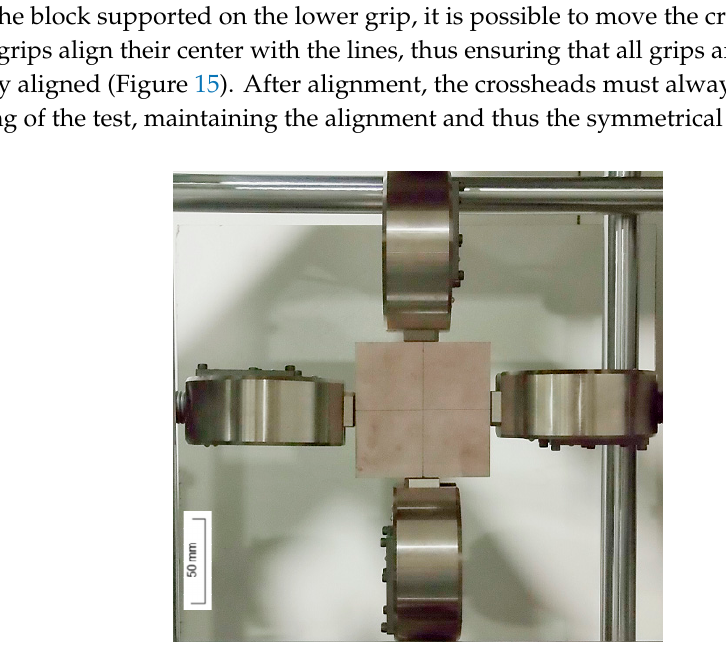
Figure 15. Gripping system alignment.